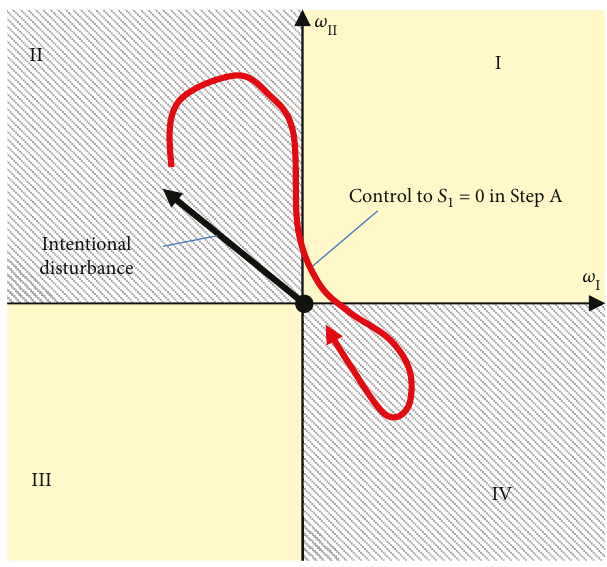
Figure 4: Trajectory of ω